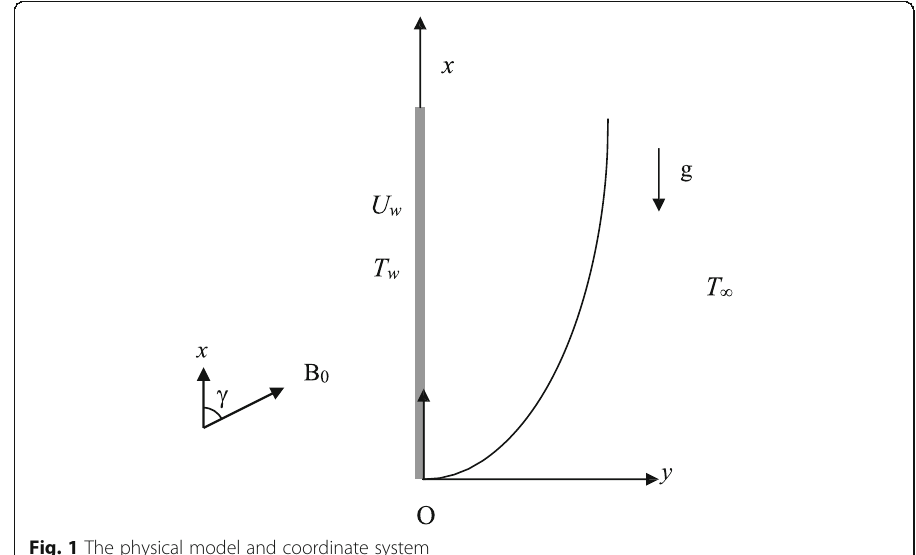
Fig. 1 The physical model and coordinate system